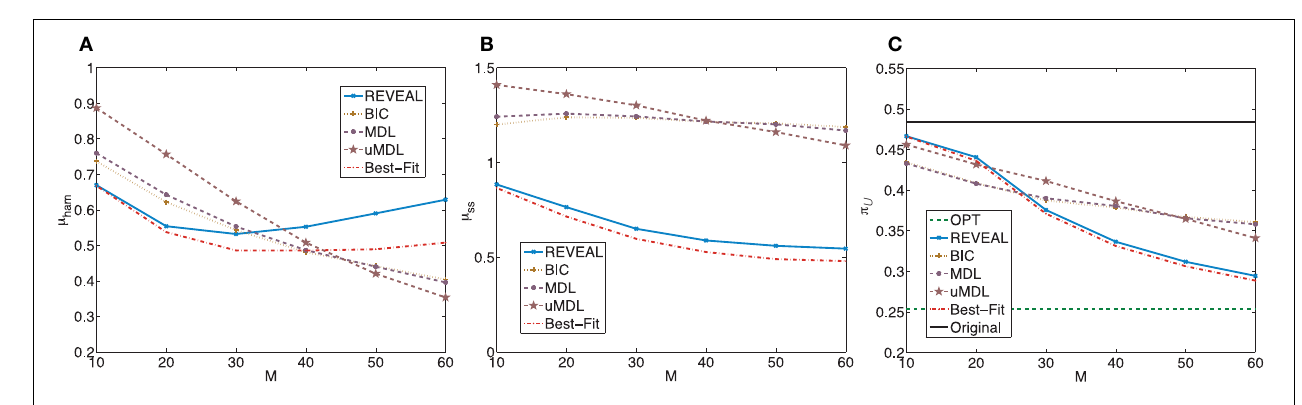
FIGURE 2 | Performance comparison of five network inference algorithms by different validity indices based on simulated BNps with 7 genes and K = 3. (A) Average normalized Hamming distance μ ham ; (B) μ ss ; (C) average undesirable steady-state mass π U after applying derived